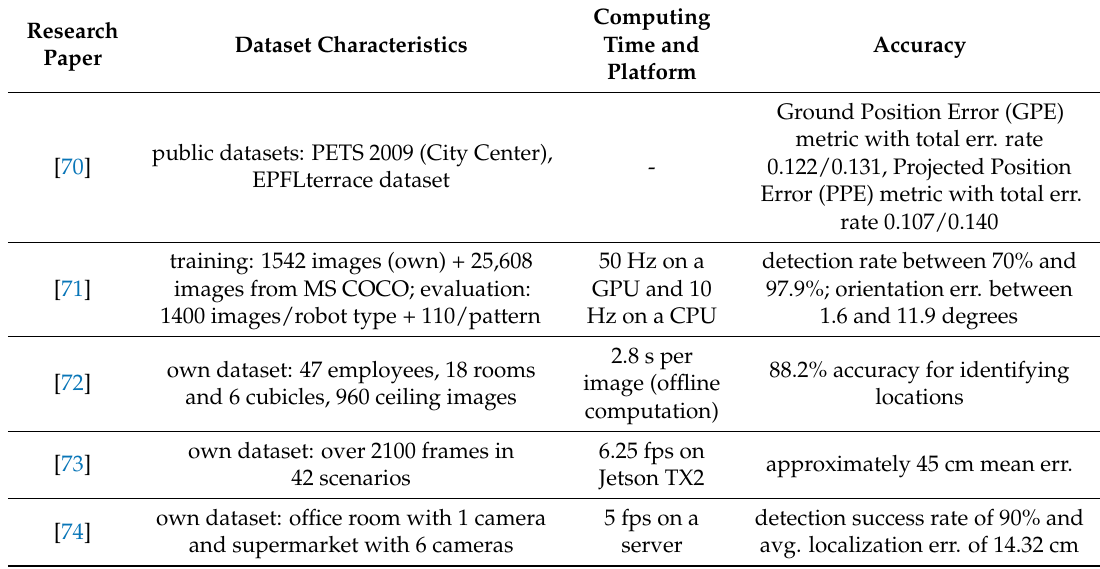
Table 4. Characteristics of indoor localization solutions with 2D static cameras (with known positions), real features, and artificial